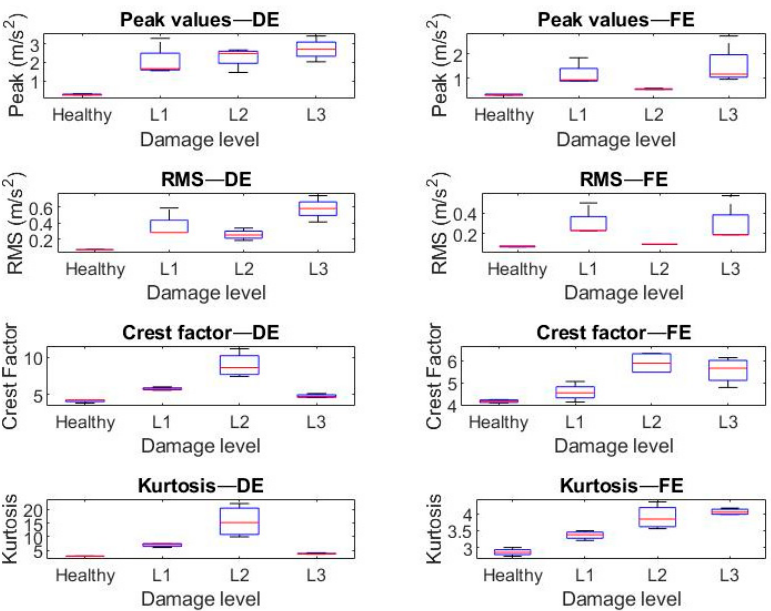
Figure 21. Boxplots for the features extracted from the vibration signal: peak value, RMS, CF and K.